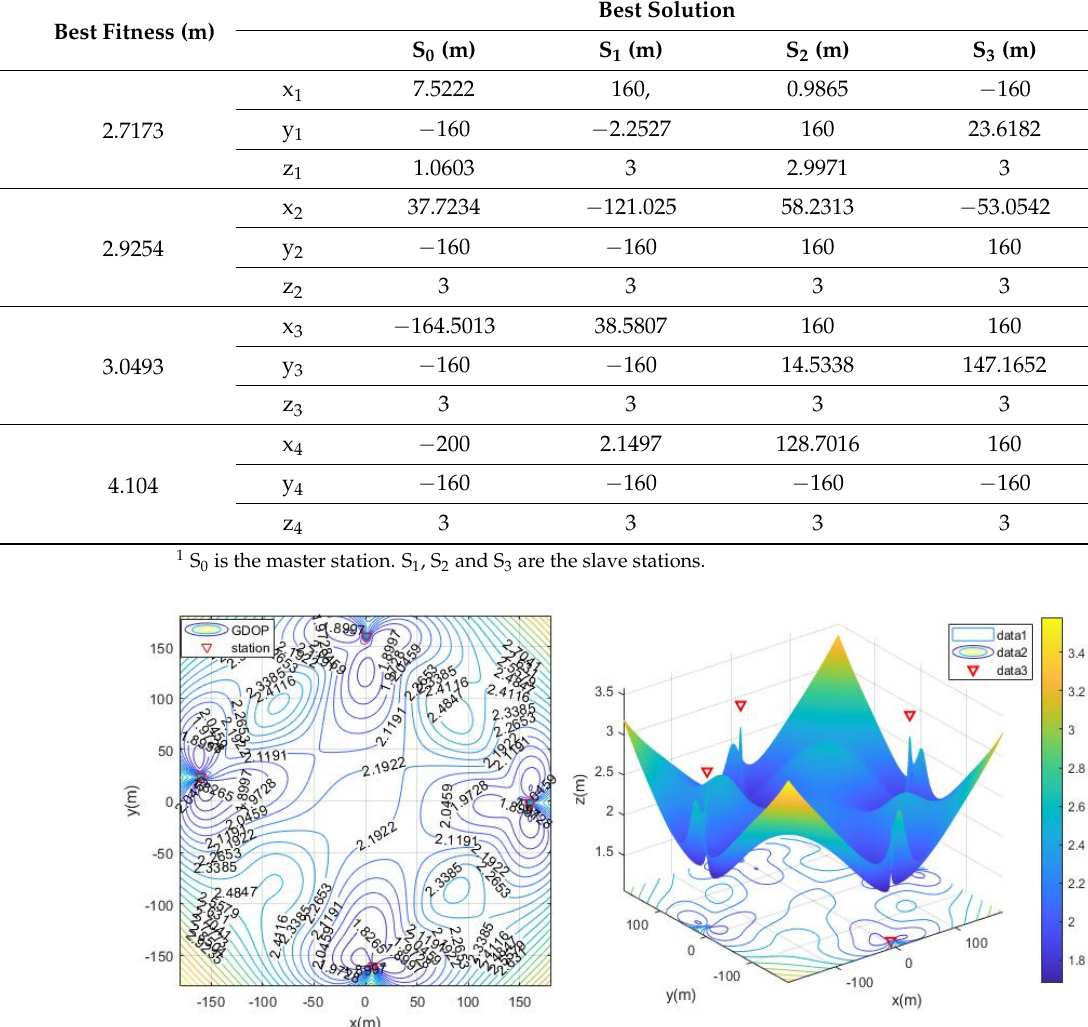
Figure 8. GDOP contour map of optimization results with 4 base stations located on both sides of the positioning area. ( a ) 2D contour map of moa02; ( b ) 3D contour map of moa02.